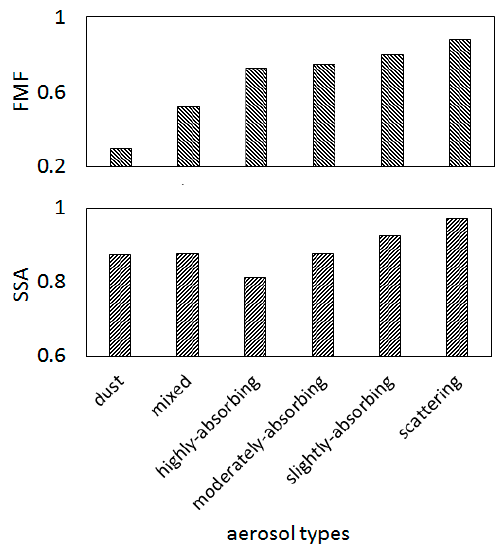
Figure 5. Average optical properties of different aerosol types (FMF and SSA).